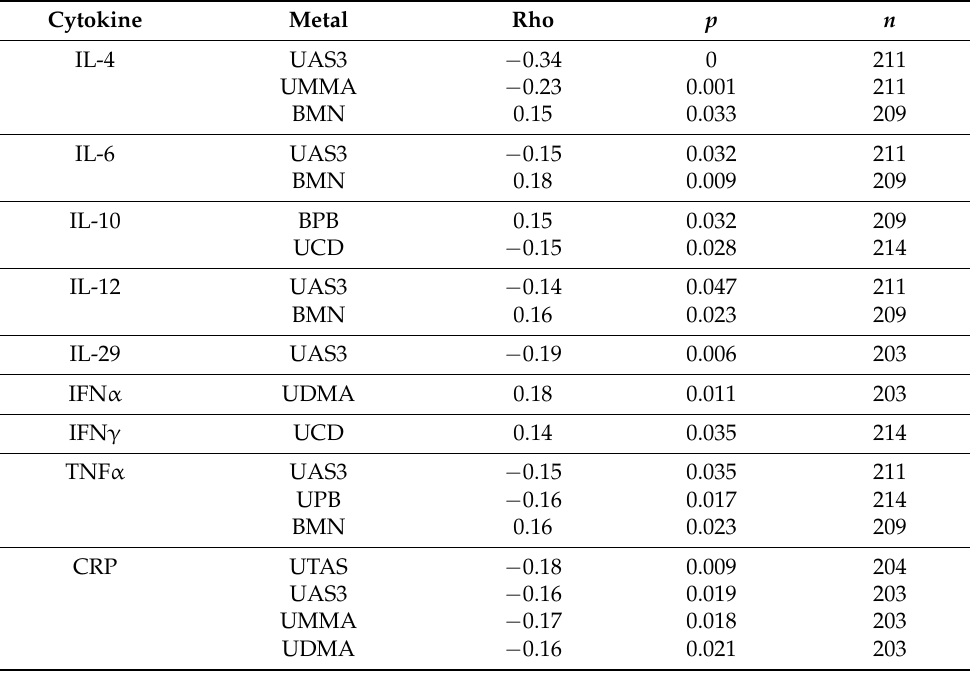
Figure 3. Spearman’s correlations between metal biomonitoring and biomarkers. Correlation coefficient is designated by color with blues designating negative correlations and reds designating positive correlations. Asterisks denote significant correlations at the p < 0.05 (*), 0.01 (**), and 0.001 (***). Table 3. Summary of significant ( p < 0.05) Spearman’s correlations between cytokines and biomonitored metals and metalloids.